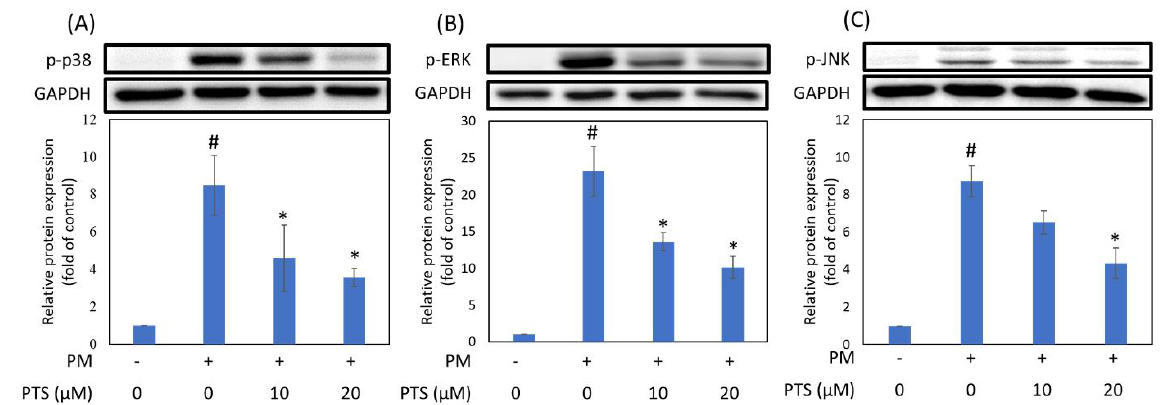
Figure 4. Expression of MAPKs in HaCaT keratinocytes exposed to PM and treated with PTS. Samples were pre-treated with PTS for 3 h, then incubated with PM for 2 h. ( A ) phospho-p38, ( B ) phospho-ERK and ( C ) phospho-JNK. # p < 0.05 compared with control. * p < 0.05 compared with only PM exposure.